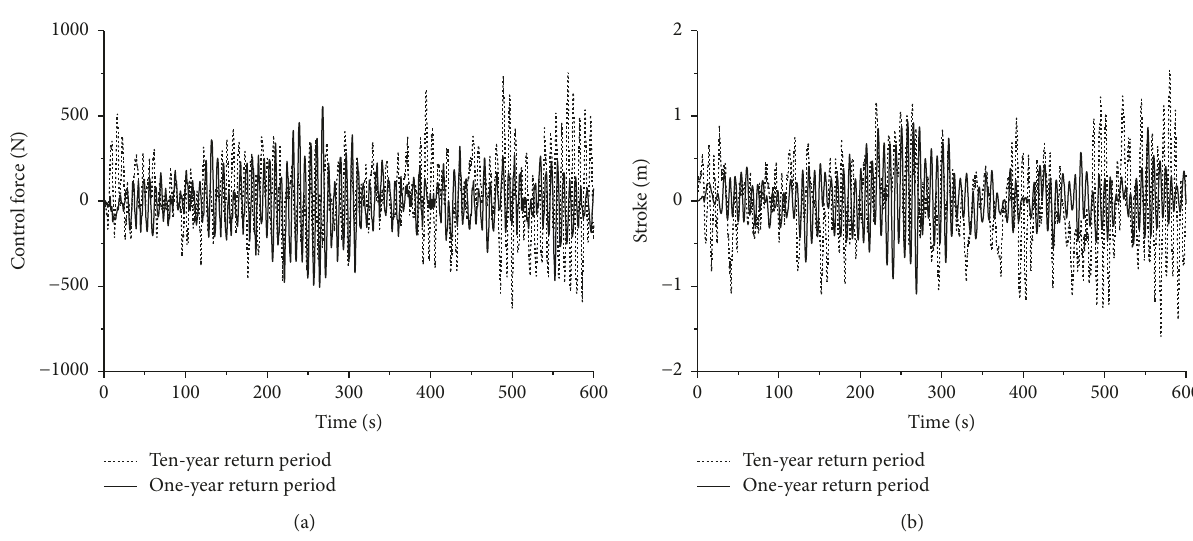
Figure 15: AMD parameters of the system with a LMI-based filter: (a) AMD control forces; (b) AMD strokes.